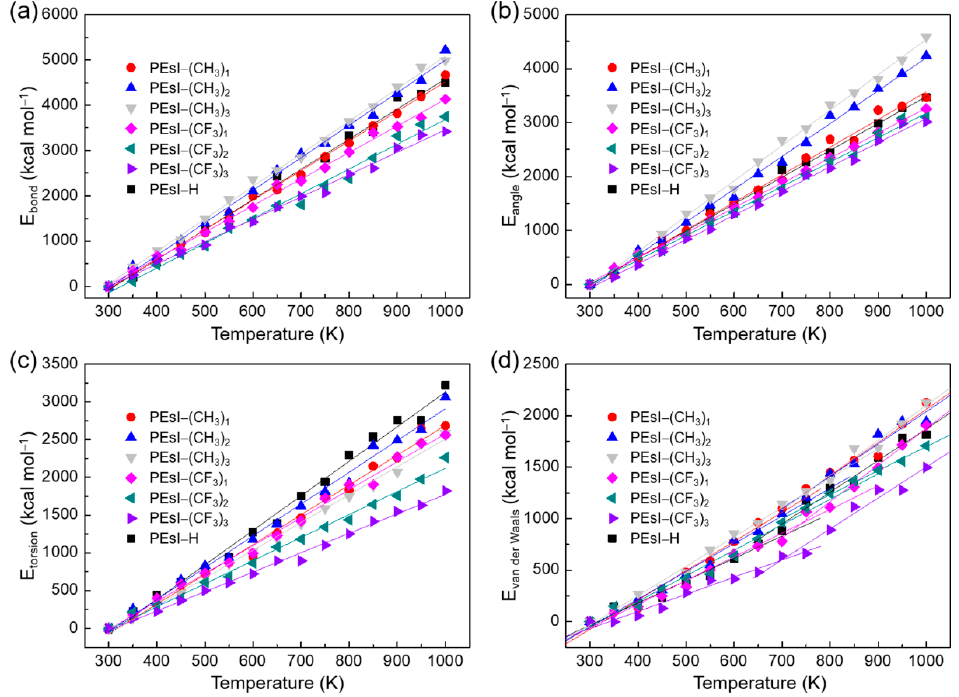
Figure 6. Plots of potential energy components versus temperature of the PEsI systems. ( a ) Bond stretching energy ( E bond ), ( b ) angle variation energy ( E angle ), ( c ) dihedral torsional energy ( E torsion ), and ( d ) van der Waals energy ( E vdW ).